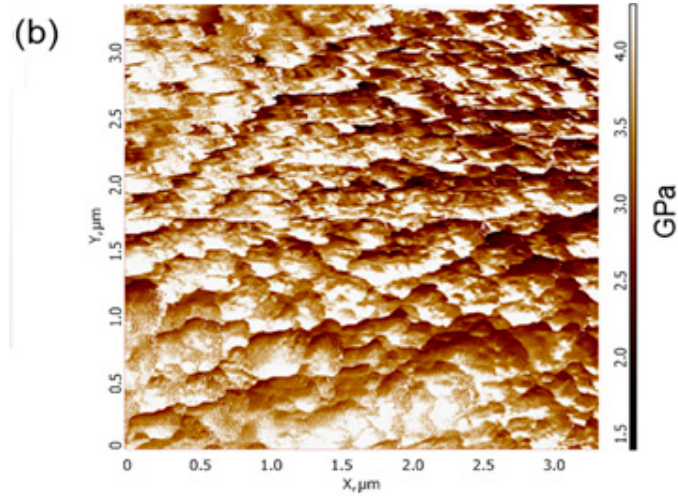
Figure 3. Topology ( a ) and Young modulus maps ( b ) of the In-Li (80 at% Li)